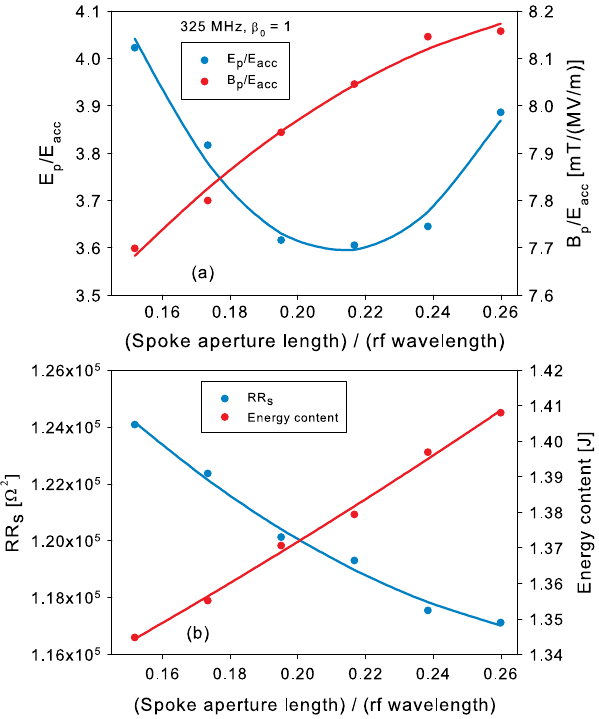
FIG. 15. (a) Dependence of the normalized electric and magnetic fields and (b) RR s and energy content (at 1 MV = m ) on the spoke aperture length.